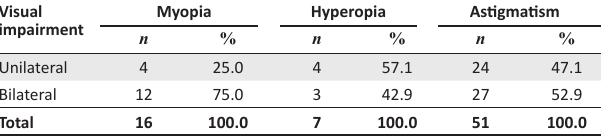
TABLE 1: Distribution of categories of visual impairment. Category of visual impairment